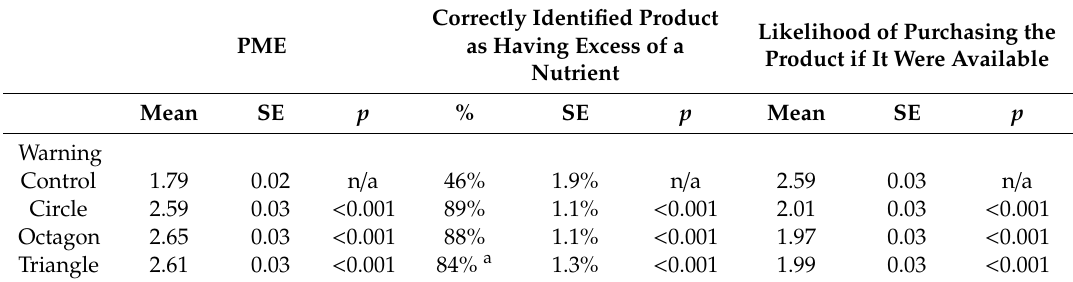
Table 2. Overall predicted means and percentages by label type, for perceived message e ff ectiveness of the label and assessment of a single product high in sugar, saturated fat, or sodium. Correctly Identified Product Likelihood of Purchasing the PME as Having Excess of a Product if It Were Available Nutrient